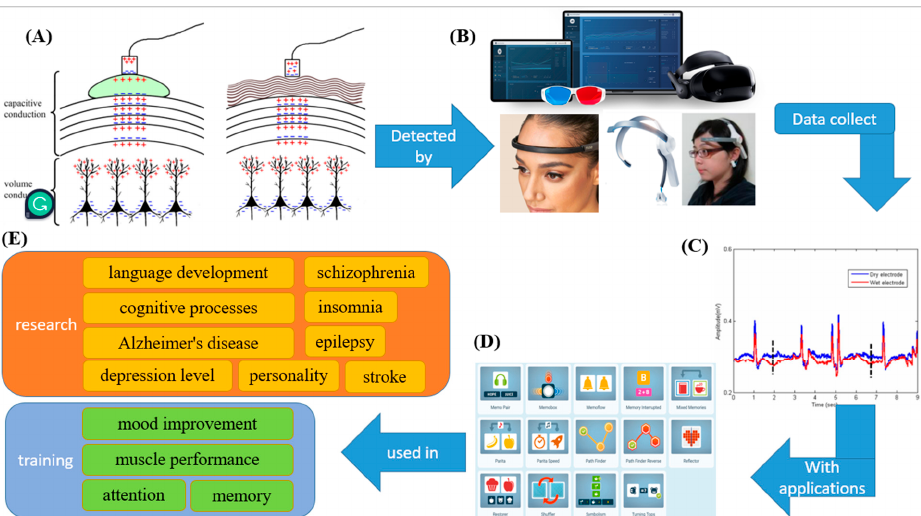
Figure 3. Wearable EEG detection device and application. ( A ) Neurons generate extracellular voltages, and the electrodes detect the sum of nearby positively and negatively charged areas. To amplify brain waves, gel or dry electrodes are essential [23]. ( B ) Wearables collect electrical signals [25]. ( C ) The data are collected and computed [24]. ( D ) Wearables can be used in various applications [26]. ( E ) The analyzed data could be used in research on depression, Alzheimer’s disease, epilepsy, schizophrenia, language development, cognitive processes, memory, attention, personality, stroke, insomnia, mood improvement, and muscle performance.